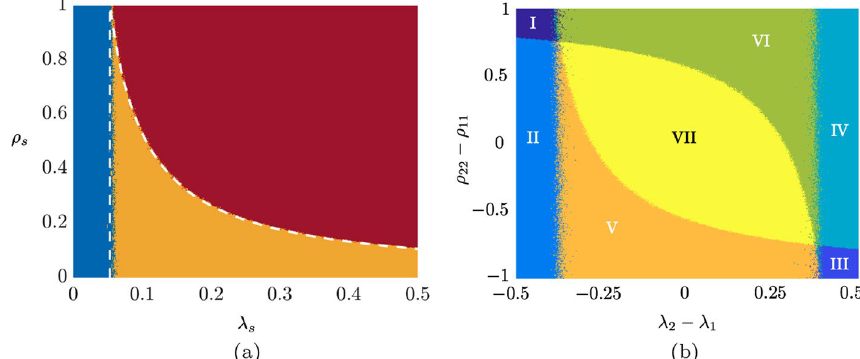
Fig. 3 Two‑dimensional diagram illustrating different types of behaviors of the stochastic network systems. In a , the two strains have equal infection and re‑infection parameters. We vary the infection parameters (cid:31) 1 = (cid:31) 2 = (cid:31) s on the interval [0, 0.5], while the re‑infection parameters ρ 11 = ρ 22 = ρ s are also varied on the interval [0, 1]. The blue region represents the non‑epidemic regime, the orange the epidemic regime, and the red the endemic regime. Dashed lines indicate theoretical predictions. In b , we vary the infection and re‑infection parameter values. Specifically, (cid:31) 1 and ρ 11 are varied on the interval [0, 0.5] and [0, 1], respectively, while we set (cid:31) 2 = 0.5 − (cid:31) 1 and ρ 22 = 1 − ρ 11 . Seven regions are highlighted, depending on the behavior of the two strains. In Region I, strain 1 is non‑epidemic and strain 2 is epidemic; in Region II, strain 1 is non‑epidemic and strain 2 is endemic; In Region III, strain 2 is non‑epidemic and strain 1 is epidemic; In Region IV, strain 2 is non‑epidemic and strain 1 is endemic; in Region V, strain 1 is epidemic and strain 2 is endemic; in Region VI, strain 2 is epidemic and strain 1 is endemic; in Region VII, both strains are